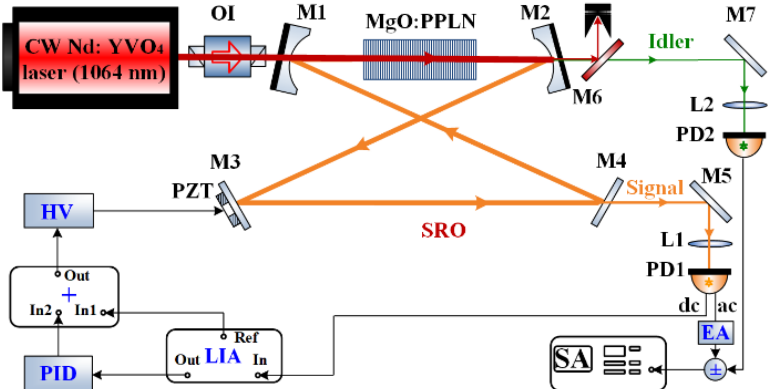
Figure 2. Schematic of the experimental setup used to generate two-color quantum correlated twin beams at 1.5 μm and 3.3 μm. OI: optical isolator; SRO: singly resonant optical parametric oscillator; beams at 1.5 µ m and 3.3 µ m. OI: optical isolator; SRO: singly resonant optical parametric